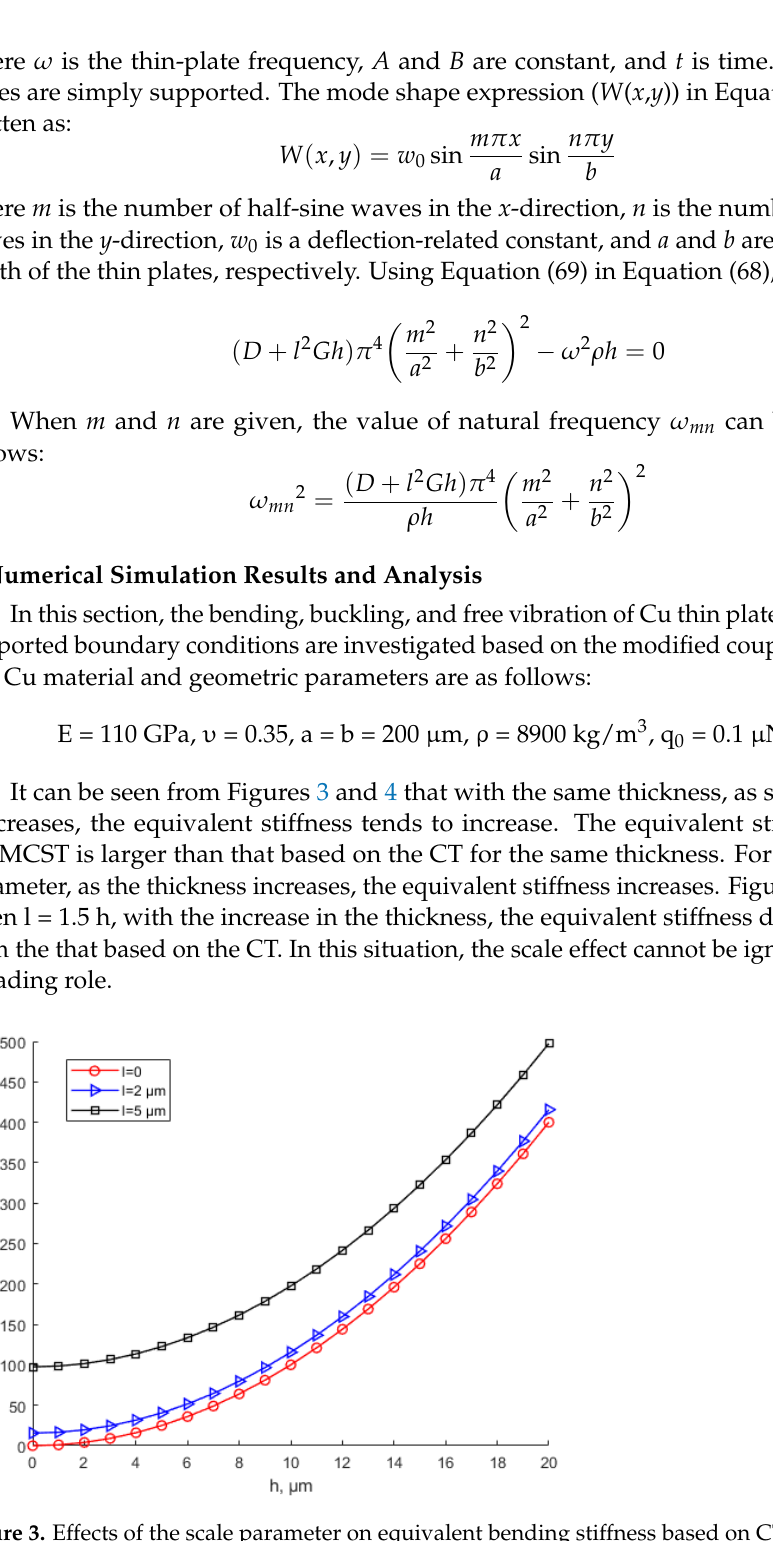
Figure 4. Effects of the scale parameter about h on equivalent bending stiffness based on CT and MCST.